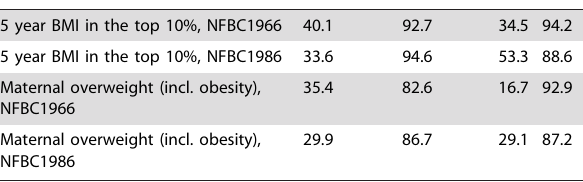
Table 6. Predictive values of 5 year BMI in the top 10% and maternal overweight (incl.